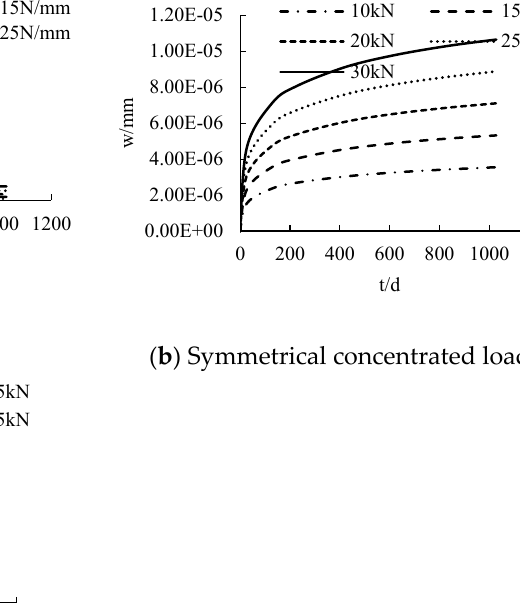
Figure 16. The influence of loading under creep on displacement.